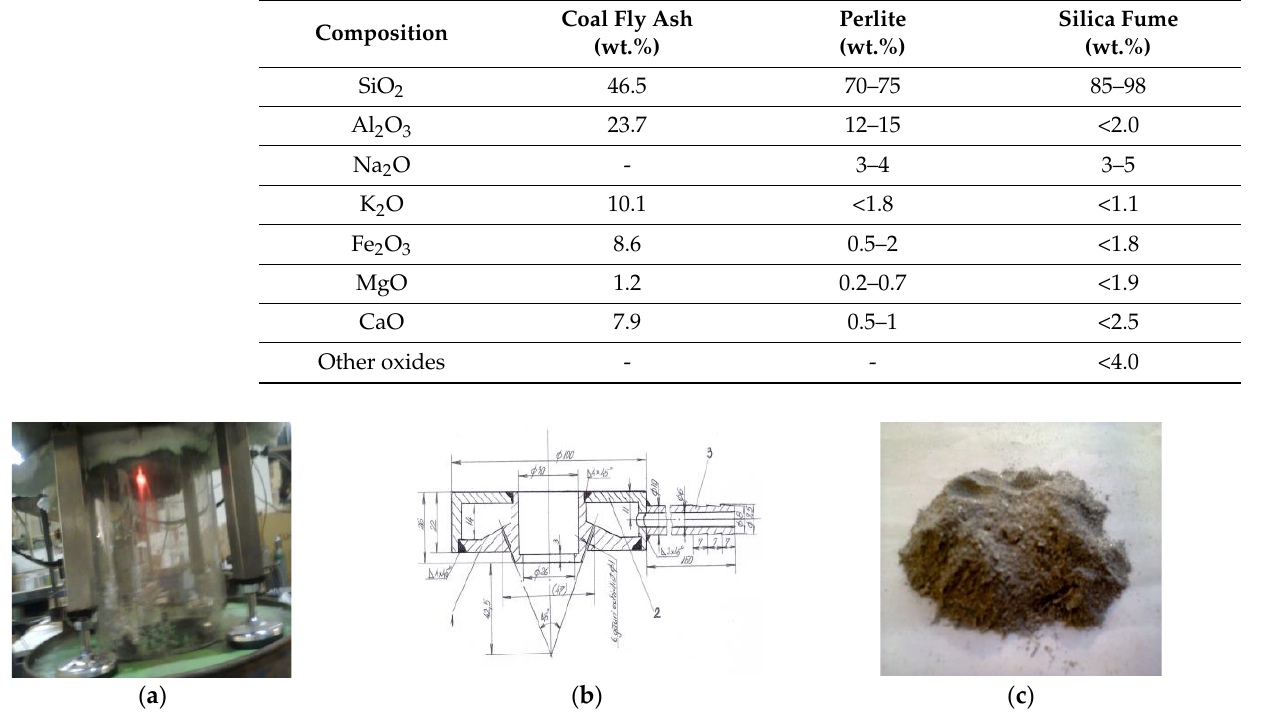
Table 1. The oxide compositions of coal fly ash, perlite, and silica fume.